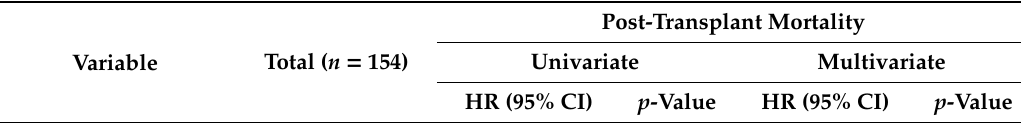
Table 5. Univariate and multivariate predictors of post-transplant